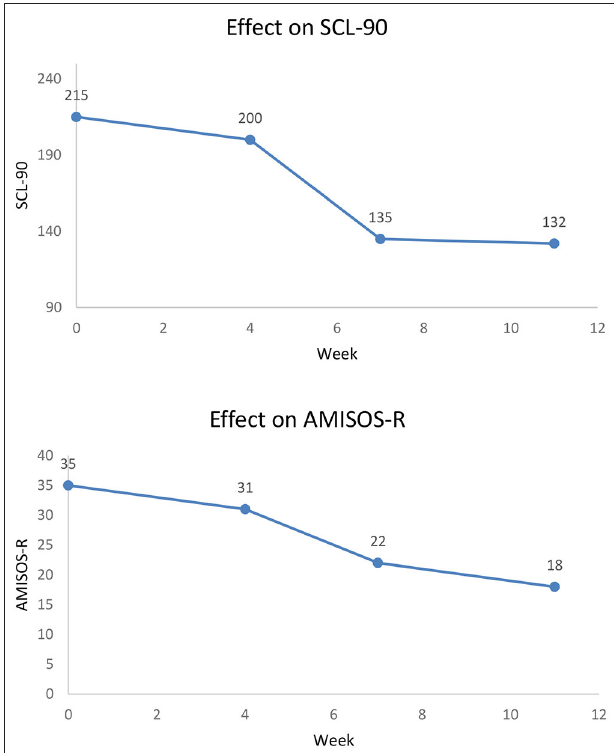
FIGURE 6 | Symptoms Charlotte during